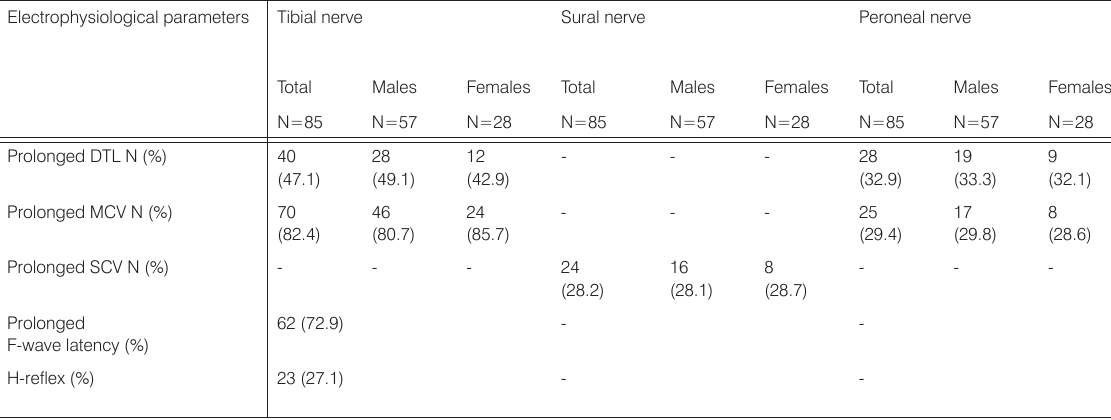
Table 2. Distribution of prolonged electrophysiological parameters Electrophysiological